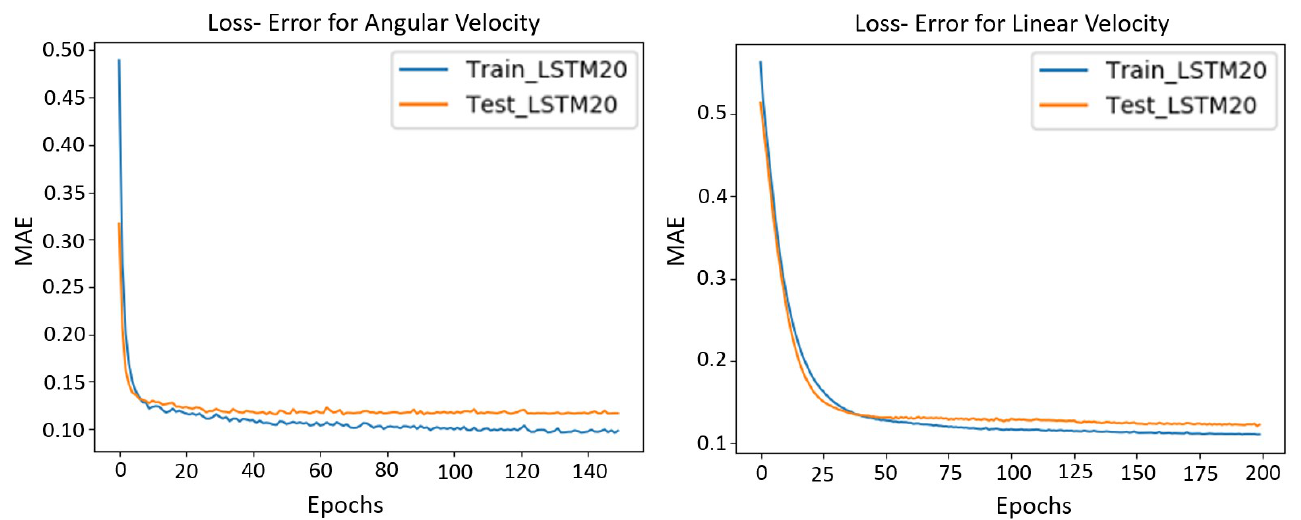
Figure 5. Loss function per epochs using the MAE for the angular and linear